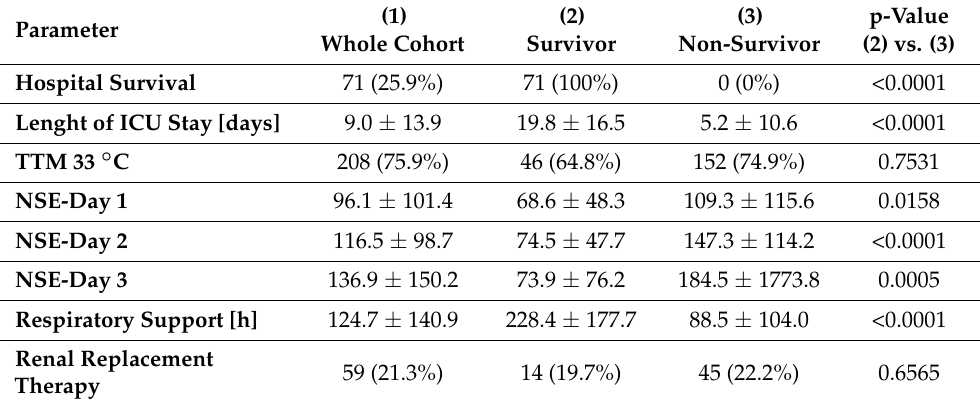
Table 3. Outcome and clinical parameters during ICU